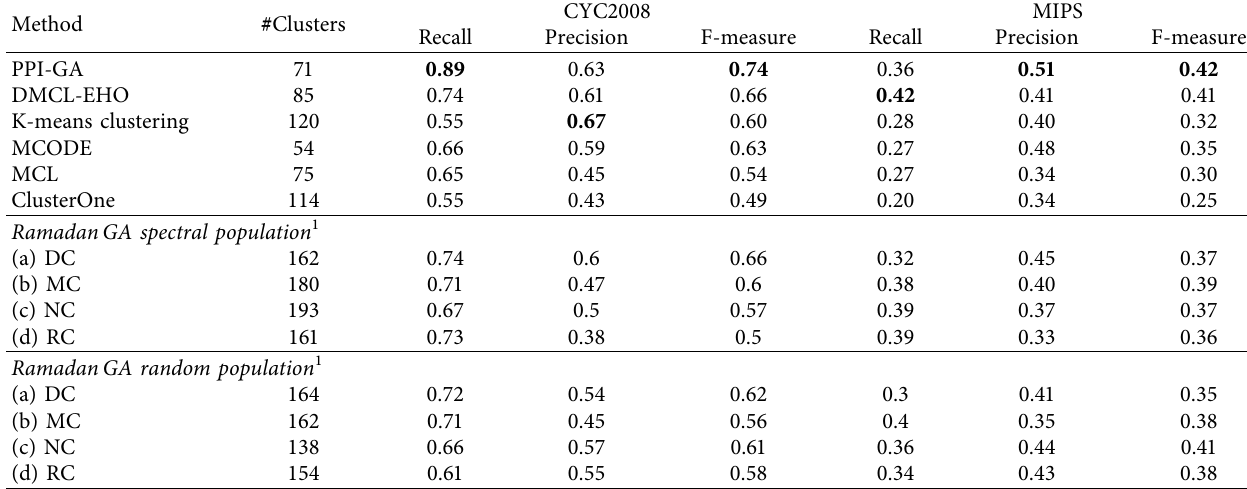
Table 10: Comparison of PPI-GA algorithm results with existing algorithm results.